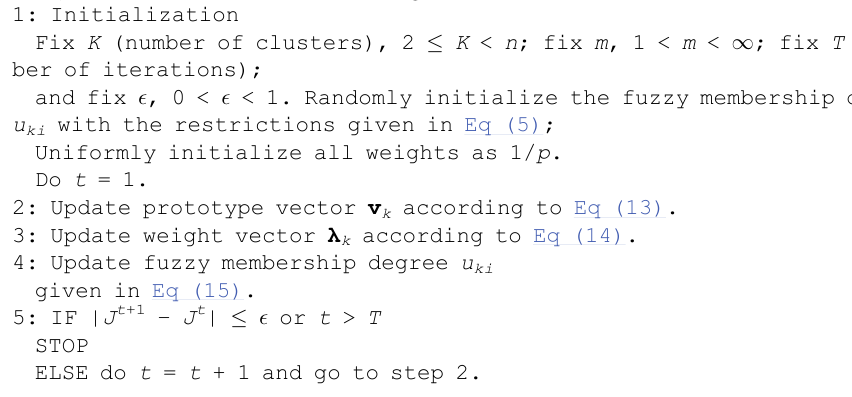
Algorithm 1 : VKFCM-K-LP clustering method